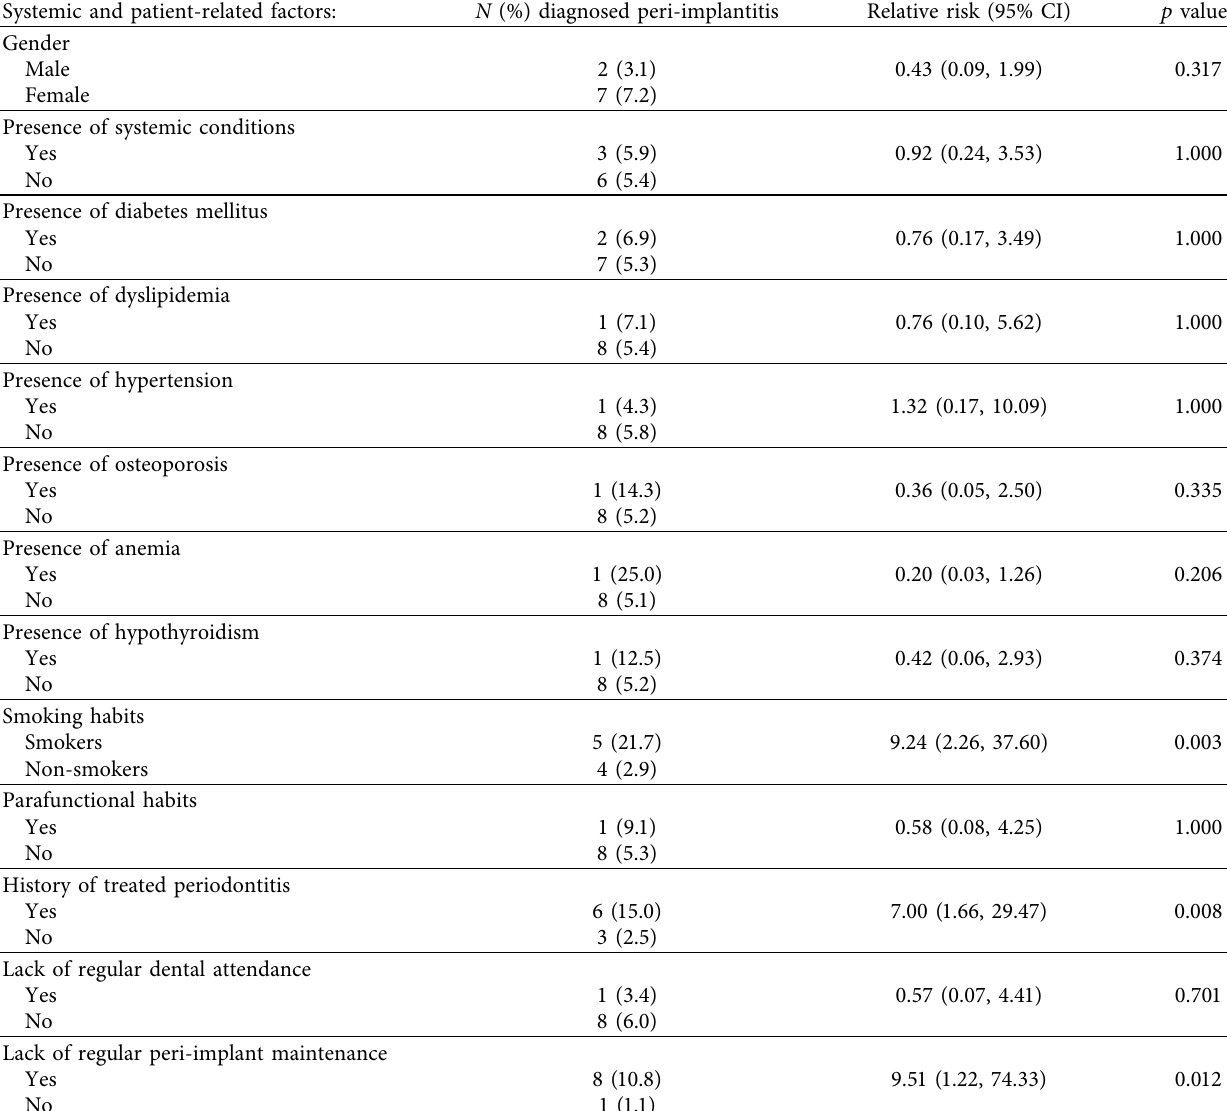
Table 3: Characteristics of patients diagnosed with peri-implantitis ( n � 162).